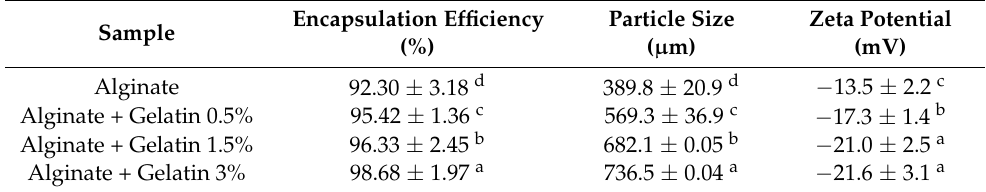
Table 1. Encapsulation efficiency, particle size, and zeta potential of capsules with different